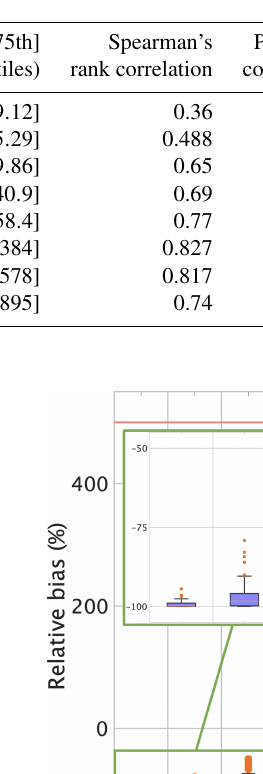
Table 3. As in Table 2 except h(x) is from incomplete 2DVD DSDs only.